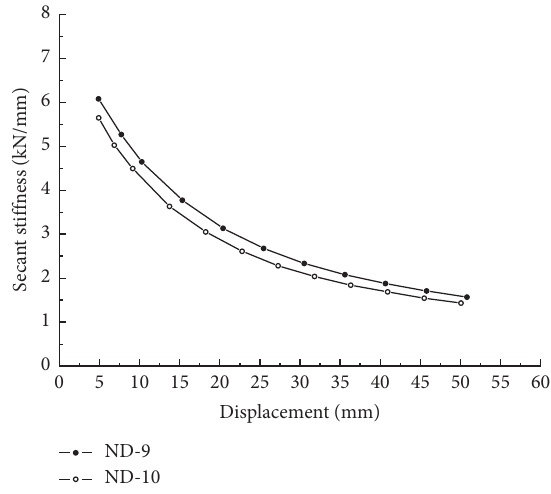
Figure 37: Stiffness curves of slit width 40mm.